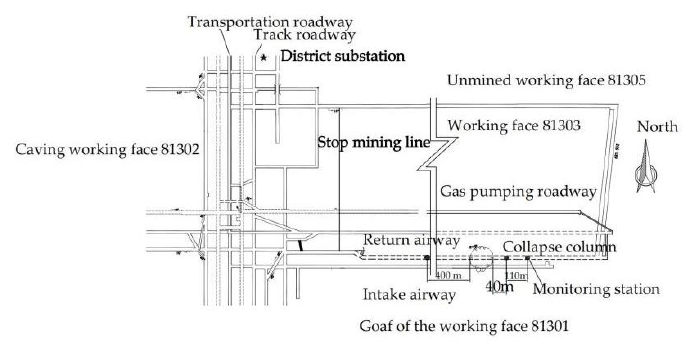
Figure 13. The roadway section deformation monitoring station layout in the return airway 81303.